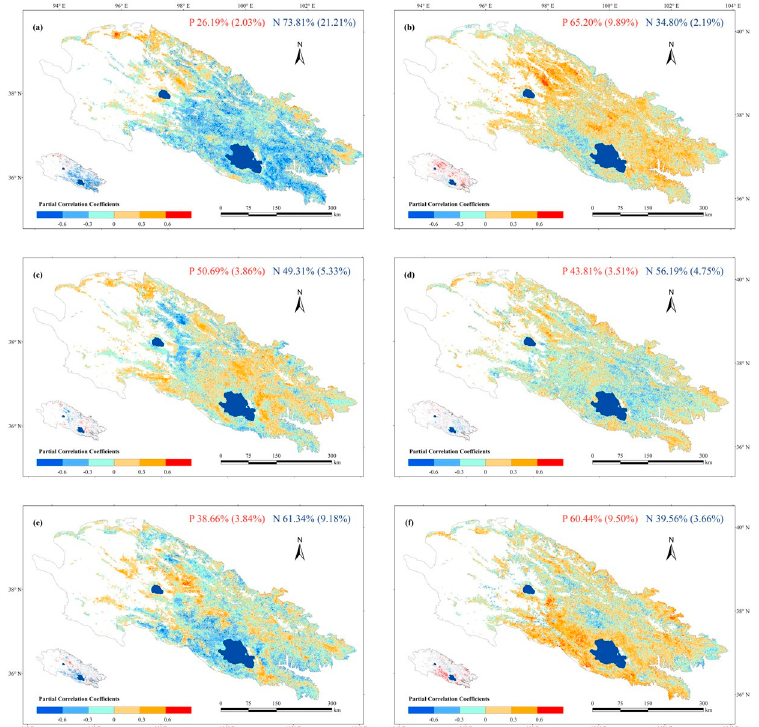
Figure 5. The partial correlation coefficients between vegetation phenology parameters and seasonal driving factors. ( a , c , e ) represent the partial correlation coefficients between the SOS and spring temperature, precipitation, and soil moisture, respectively. ( b , d , f ) represent the partial correlation coefficients between the EOS and autumn temperature, precipitation, and soil moisture, respectively. The inset panels on the bottom left of each subpicture present pixels with a significantly ( p < 0.05) negative (blue) and positive (red) correlation. The percentages of positive (P) and negative (N) correlations (the values in brackets indicate the percentage of significant correlations) are shown at the top of each subpicture.